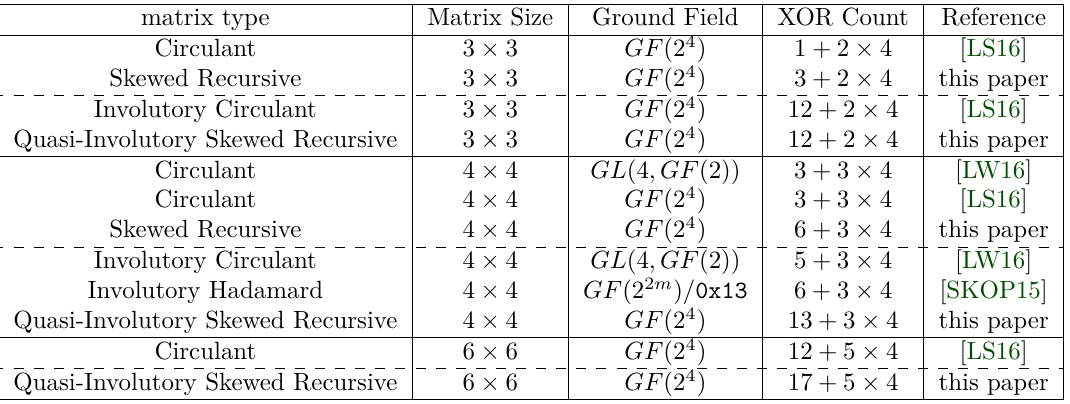
elements without counting the necessary cost 2 4